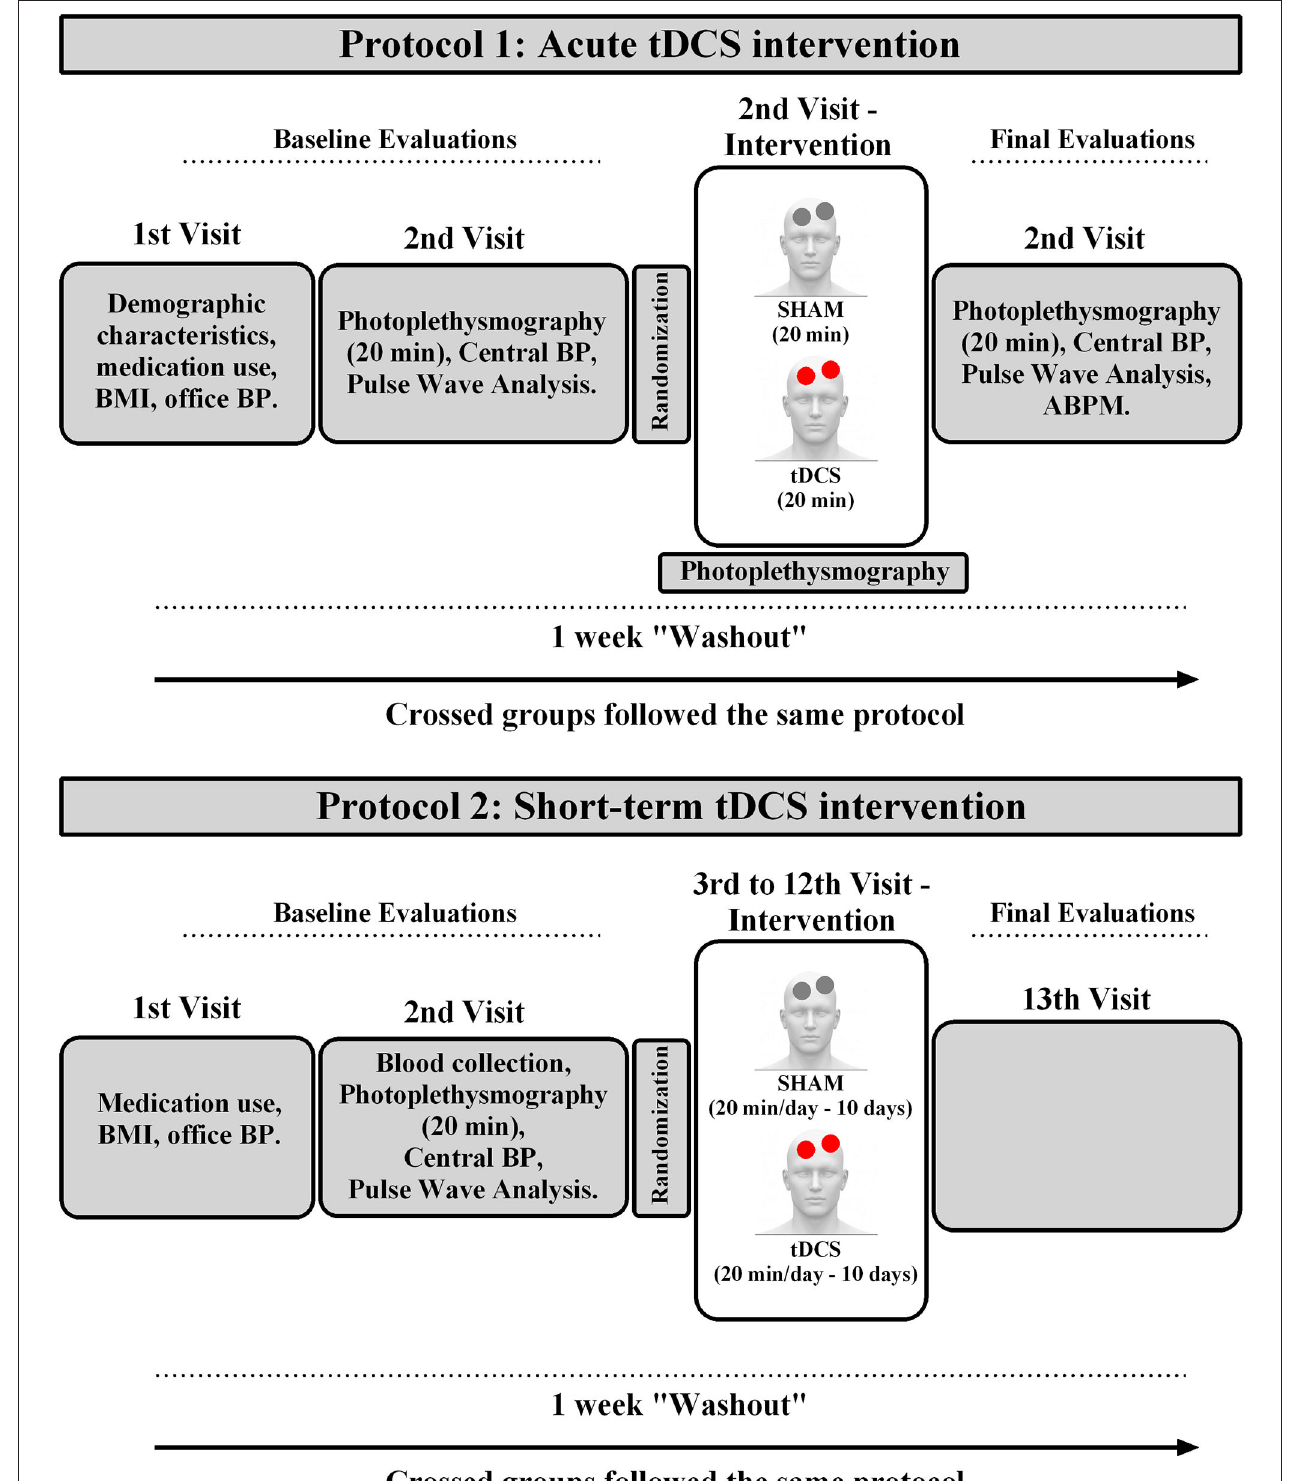
FIGURE 1 | Experimental design. BMI, body mass index; ABPM, ambulatory blood pressure measurement.